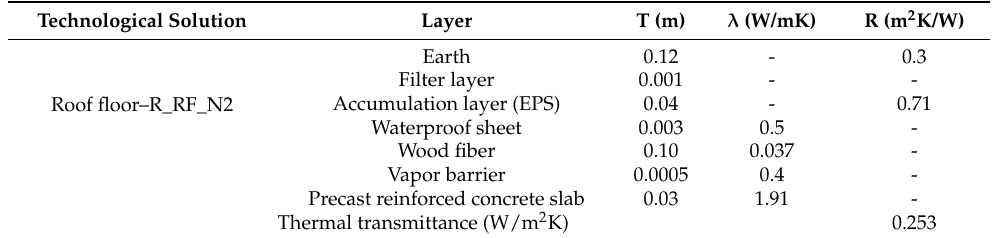
Table A28. Possible redevelopment measure for roof floor with green roof as the finishing layer